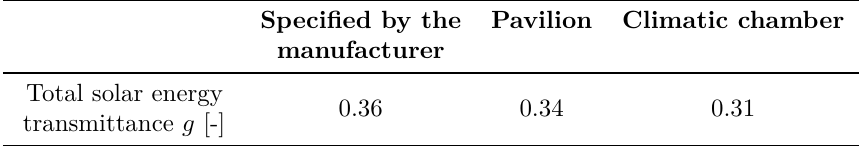
Table 4. Total solar energy transmittance g